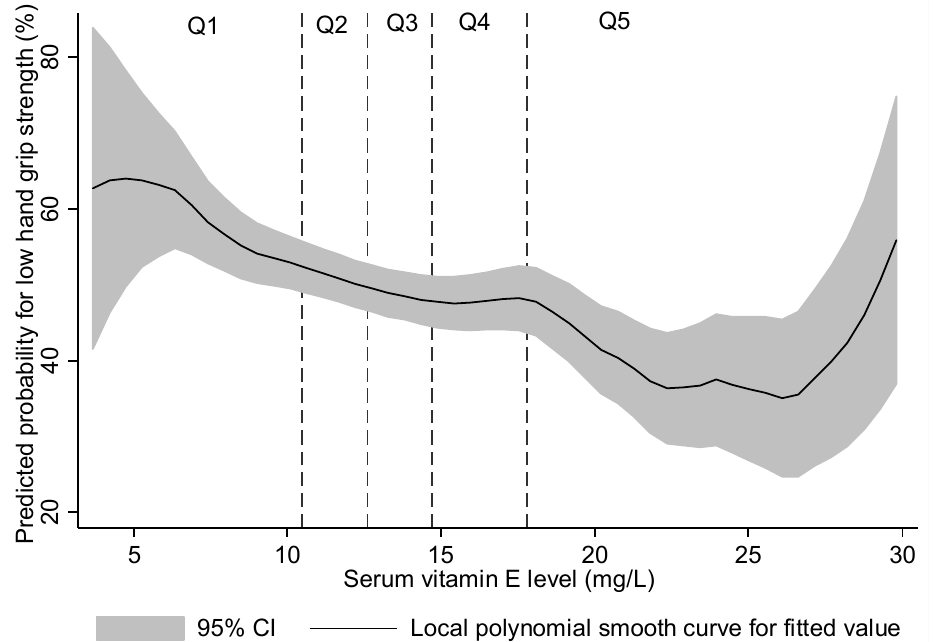
Figure 2. Predicted probability for low hand grip strength (below the sex-stratified median) using a local polynomial smooth curve.